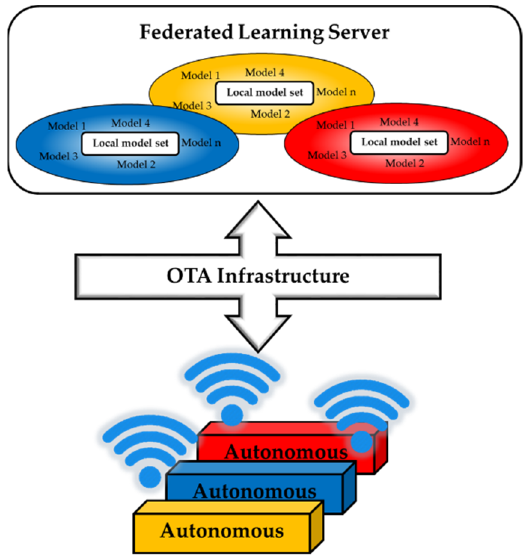
Figure 7. The system sends models Over-the-Air for federated learning.